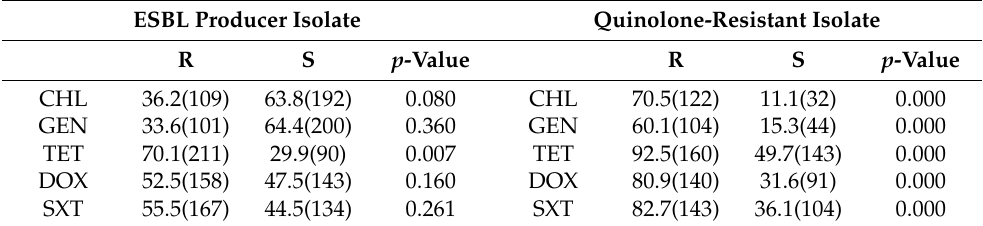
Table 8. Comparative results of ESBL producers against quinolone-resistant E. coli isolates.